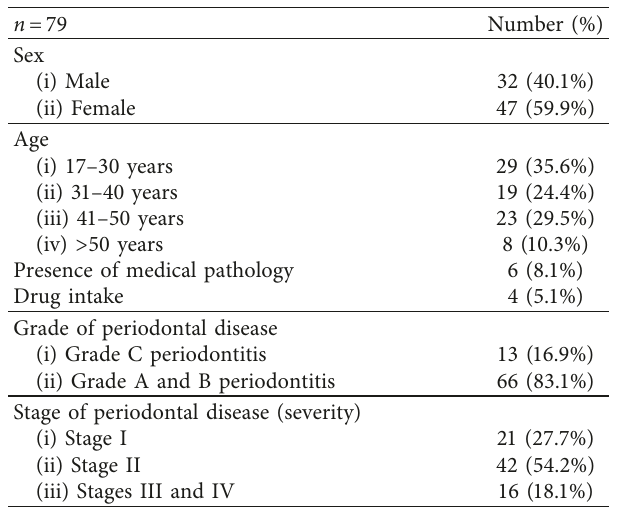
Table 1: Characteristics of the study population (79 patient